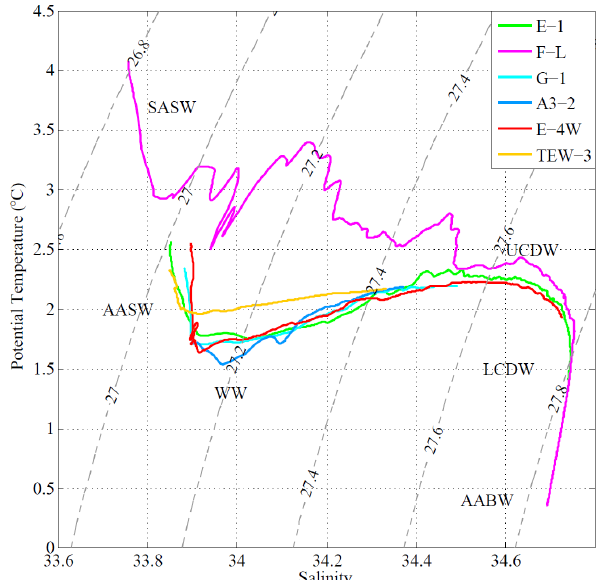
Figure 3. Potential-temperature–salinity diagrams at stations where radium analyses were performed. The main water masses are re- ported on the figure: Antarctic Surface Water (AASW), Subantarc- tic Surface Water (SASW), Winter Water (WW), Upper Circumpo- lar Deep Water (UCDW), Lower Circumpolar Deep Water (LCDW) and Antarctic Bottom Water